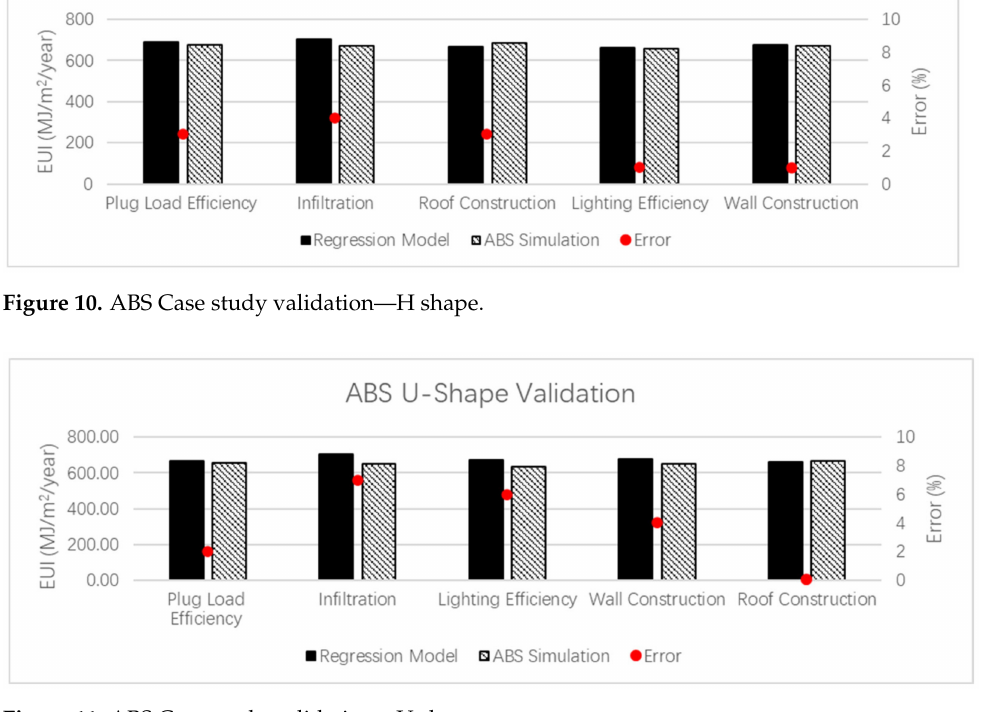
Figure 11. ABS Case study validation—U shape.